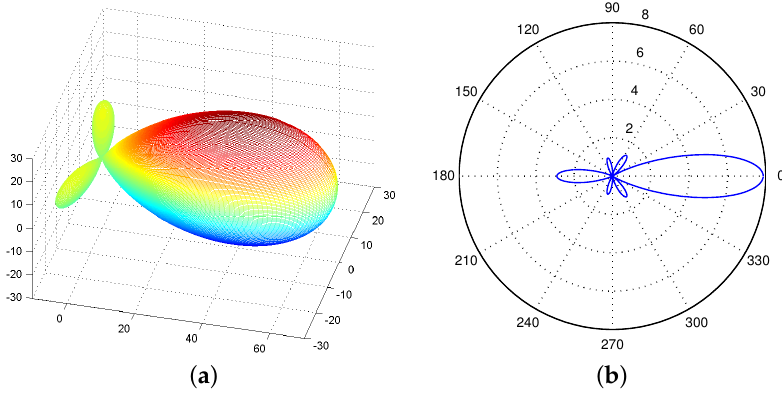
Figure 3. Radiation pattern of a UCA antenna. ( a ) In 3D space; ( b ) on a 2D